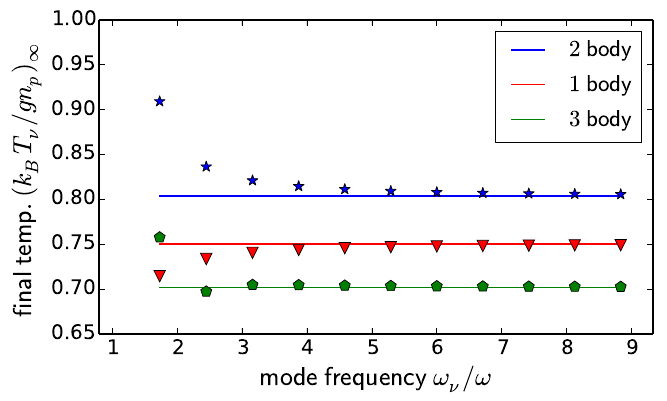
T / mc 2 for hydrodynamic collective modes Figure 2: Asymptotic ratio y ∞ = k B of a 1D quasi-condensate confined in a harmonic trap, for 1-body (red), 2-body (blue) and 3-body (green) losses. The modes are labeled by their eigenfrequen- (cid:112) ν ( ν + cies ω ν = ω 1 ) / 2 and we only consider ν ≥ 2. Symbols: calculation based on the Legendre polynomials of Eq.(34), inserted into Eqs. (24, 25). Solid lines: large- ν approximation given by Eq. (36) with values y ∞ = 3 / 4,45 / 56,525 / 748 for j =